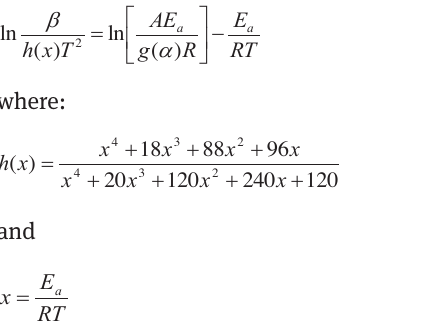
Figure 4: Line chart for thermal decomposition of NPL-10.